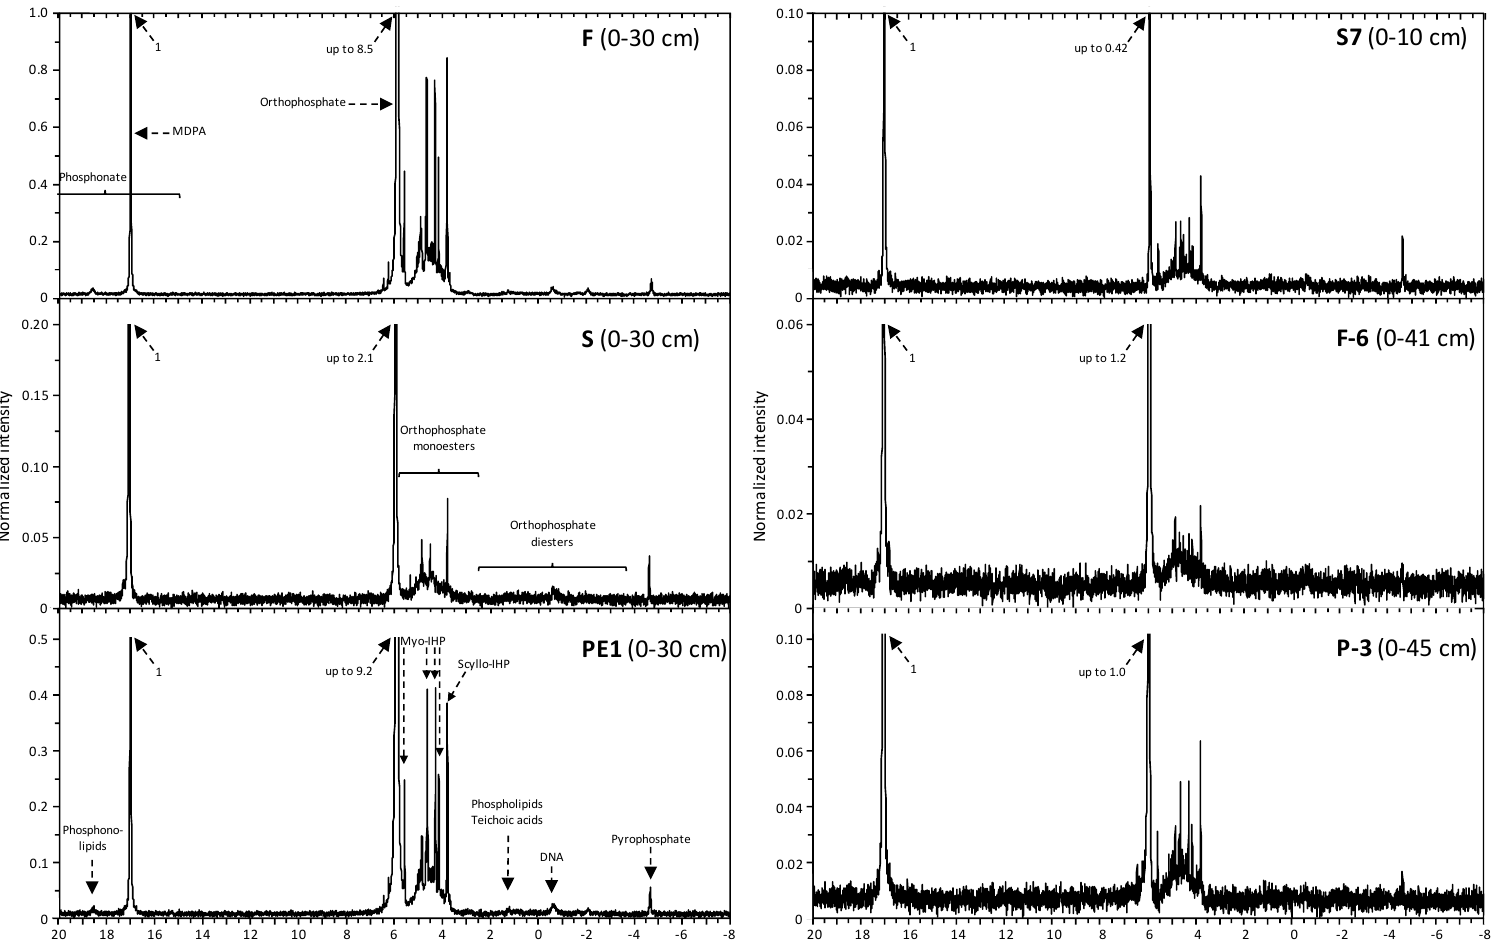
Figure 4. 31 P nuclear magnetic resonance ( 31 P-NMR) spectra of NaOH-EDTA extracts of six Northern European soils (F: Feøy; S: Sandhåland; PE1: Njærheim; S7: Vordingborg; F-6: Großenbrode; P-3: Niendorf). The vertical scale was standardized to 1 based on the MDPA peak (methylene diphosphonic acid). Detailed illustrations of the monoester regions (6.5 to 6.2 ppm and 5.7 to 2.5 ppm) including peak assignments are shown in Acksel et al. [86].